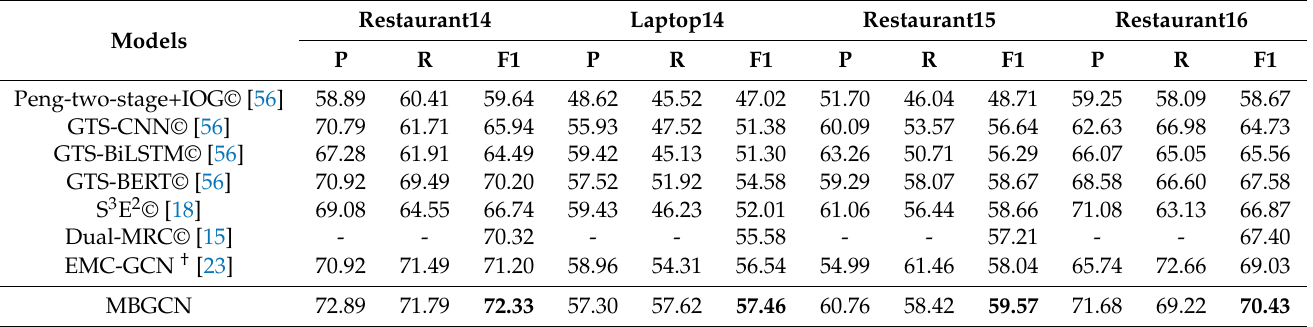
Table 3. The performance of Multi-branches Graph Convolutional Network (MBGCN) on V 1 .